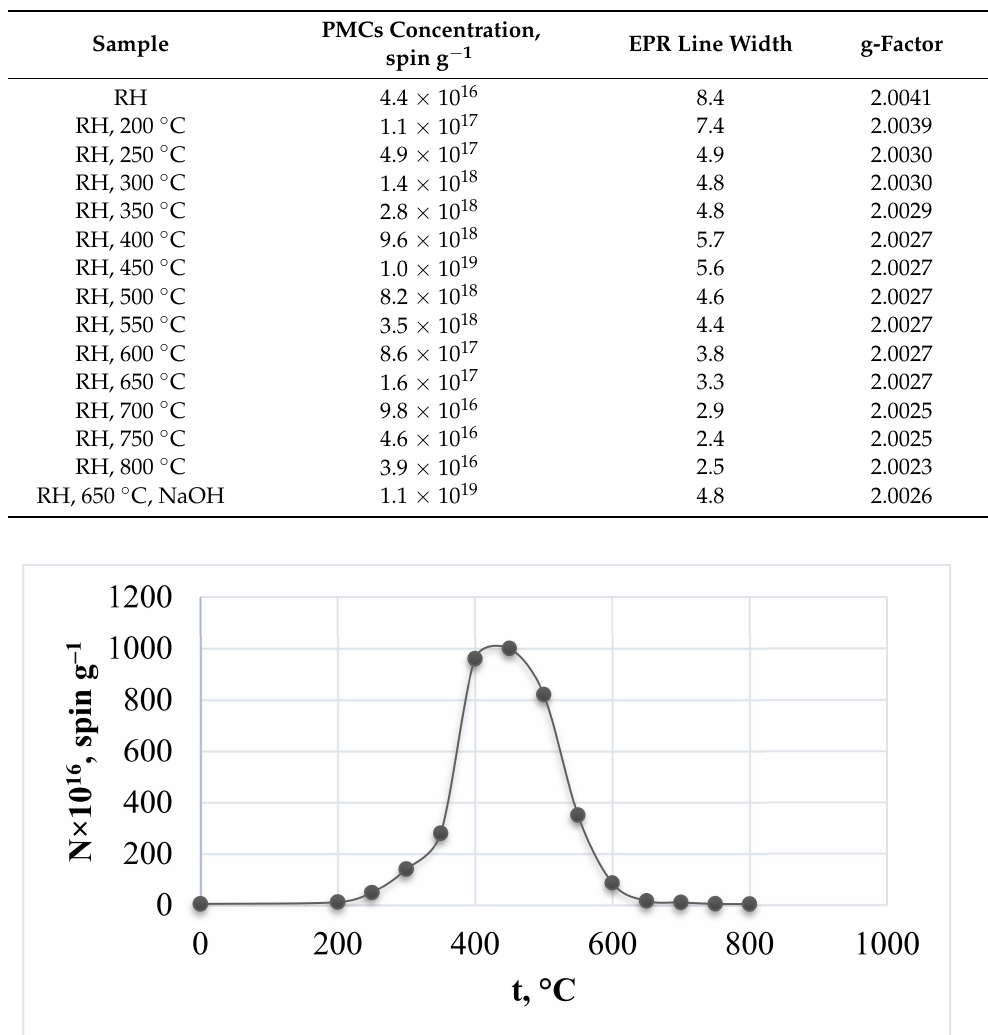
Table 1. Parameters of EPR spectra of original and carbonized rice husk.